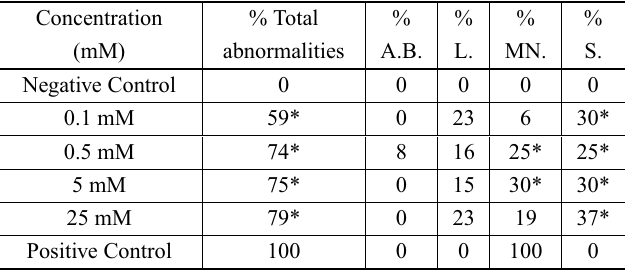
Mitotic aberrations in the root tip cells of A. cepa treated different NDEA concentrations.